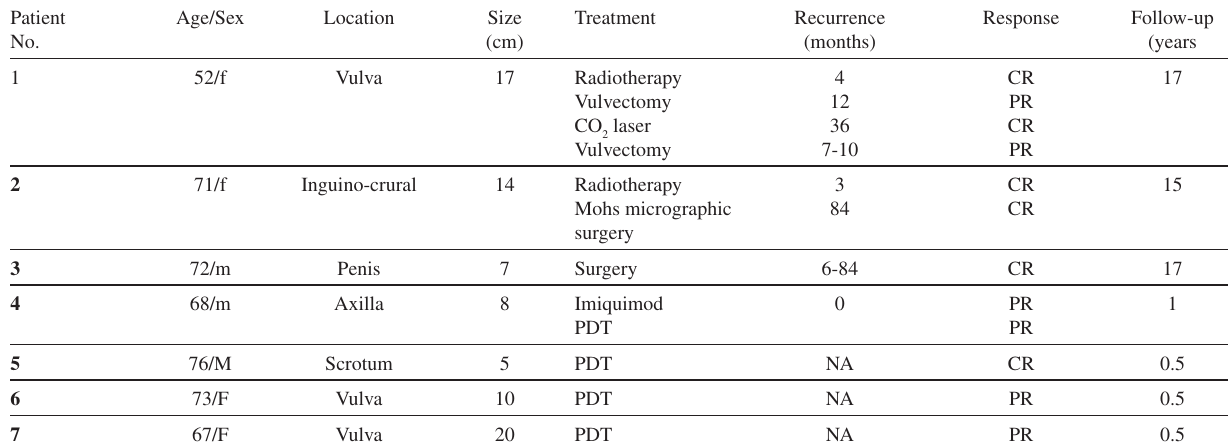
Table 1 - The clinical characteristics and treatments of the patients with EMPD Patient